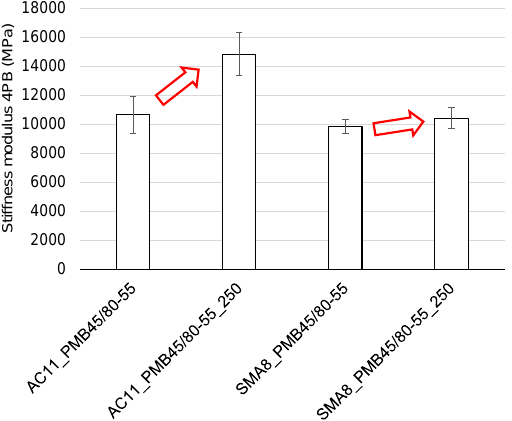
Materials 2019 , 12 , x FOR PEER REVIEW 15 of 20 temperature T (ODI) . However, there are property changes at a temperature of 250 °C, which is shown in Figures 13 – 15.